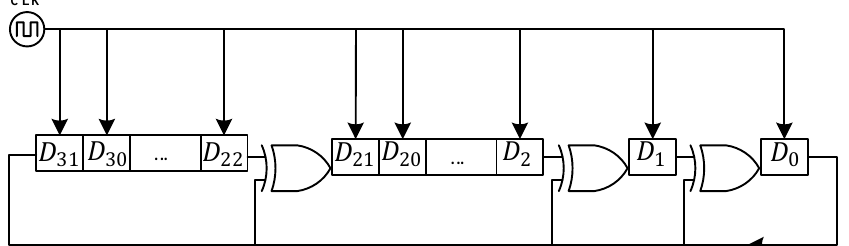
Figure 1. Circuit Diagram of 32-bit (internal feedback)